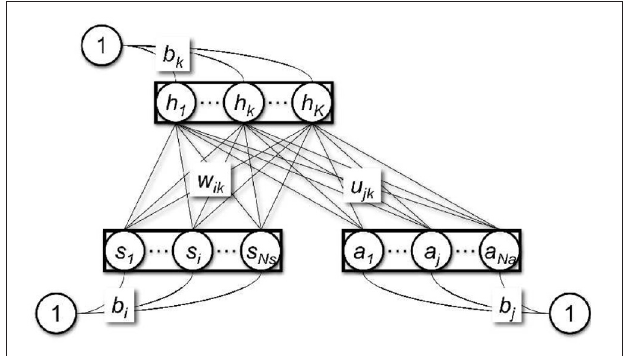
FIGURE 1 | Restricted Boltzmann